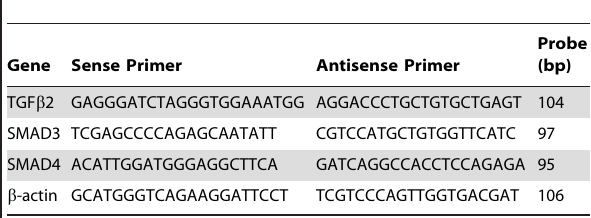
Table 1. Human Primer Sequences Used for Realtime RT-PCR.